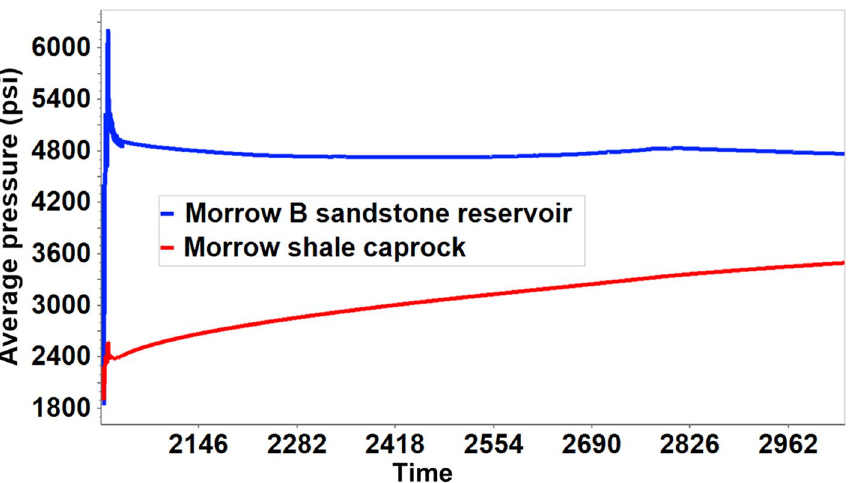
Figure 11. The average pressure within the Morrow B sandstone reservoir and the Morrow shale caprock over time.